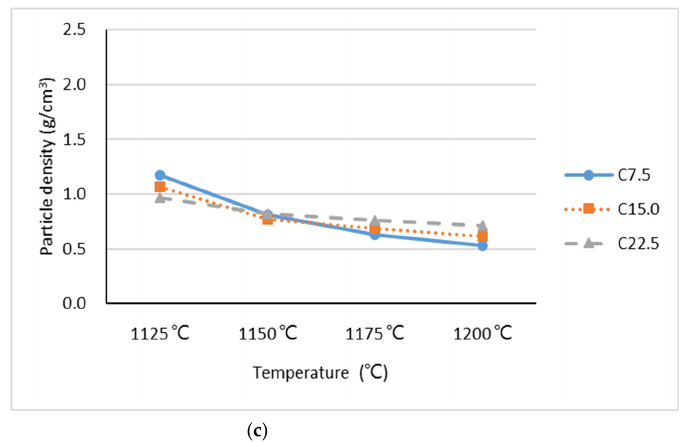
Figure 3. Particle density of lightweight aggregates at Stage I mixed with ( a ) Industrial Sludge A,